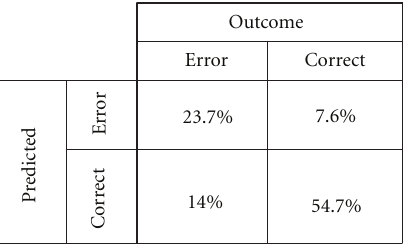
Figure 4: Confusion matrix for ErrP detection (group